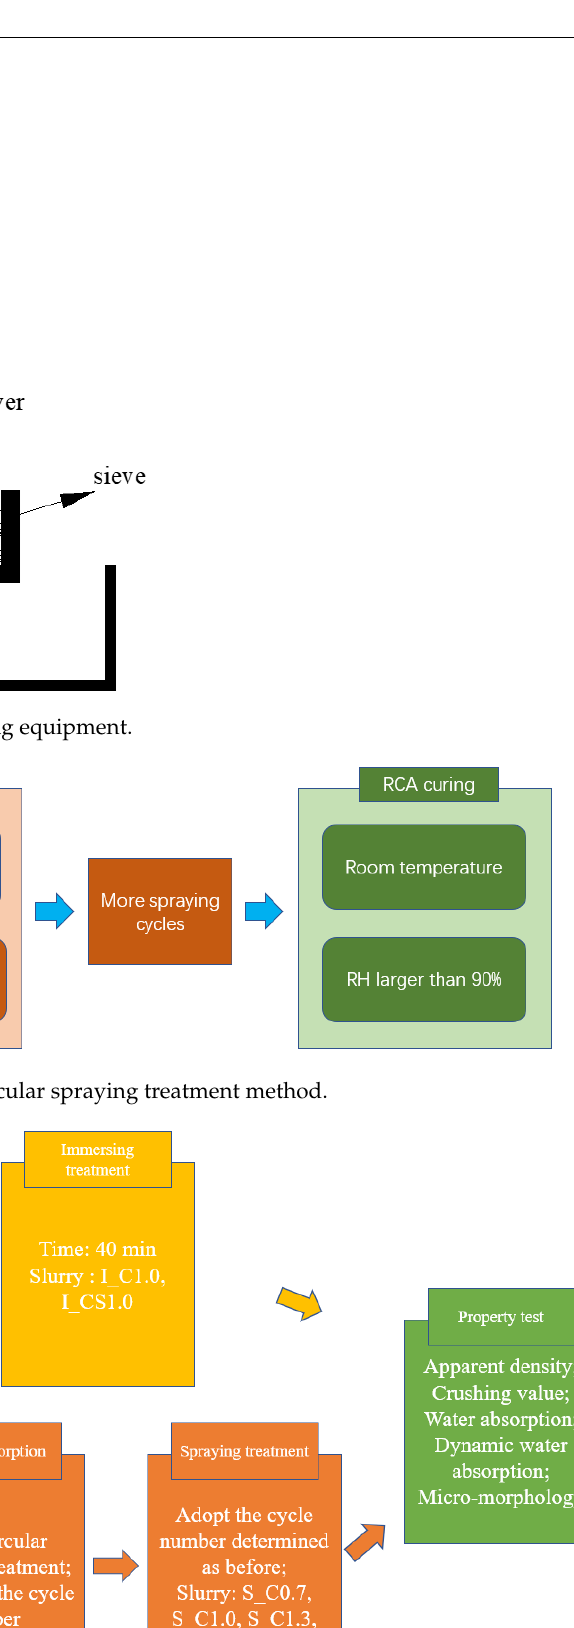
Figure 5. The procedure of the experiment.